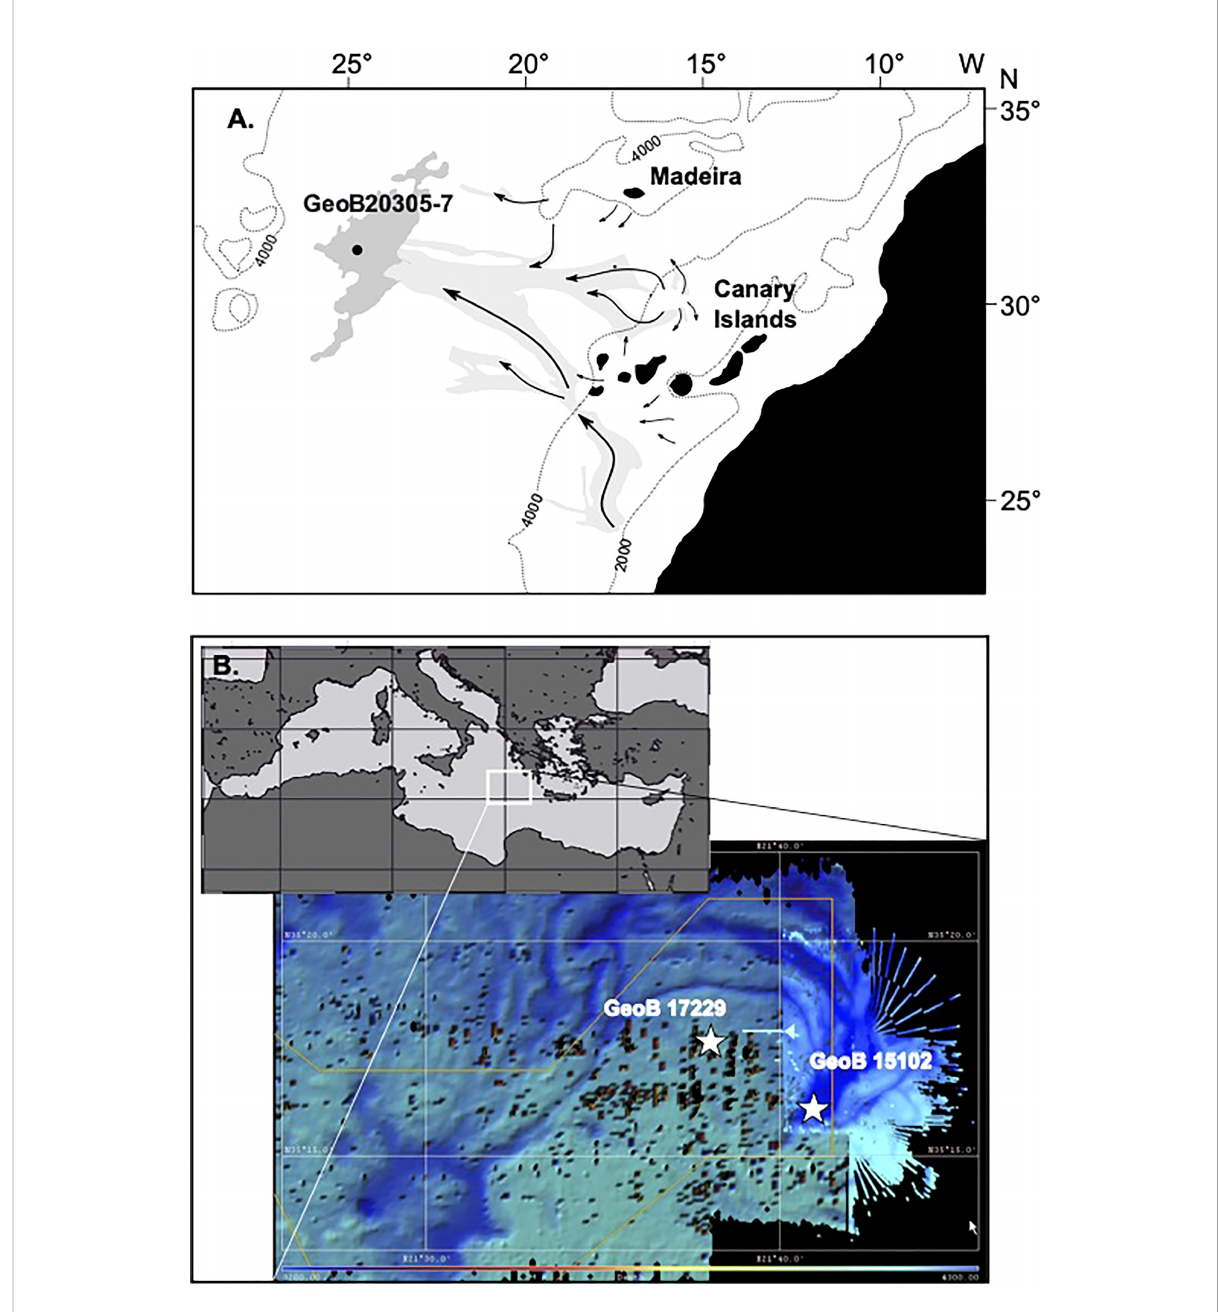
FIGURE 1 Maps of the core positions on (A) the equatorial Atlantic Ocean off NW Africa depicting the 4000 m and 2000 m depth contours, the position of the Madeira Abyssal Plain (dark grey), major turbidity fl ow paths (light gray and arrows) and core position. (redrawn from Zonneveld et al., 2019) (B) Map of the Mediterranean Sea with location of the Discovery Basin. Depth contour map with positions of the core